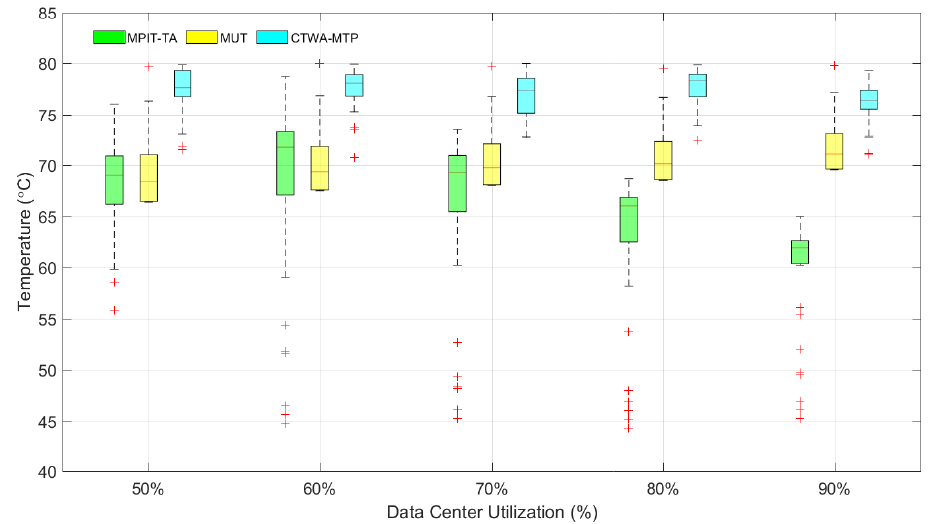
Figure 7. Boxplot for chip temperature distributions with different data center utilizations.